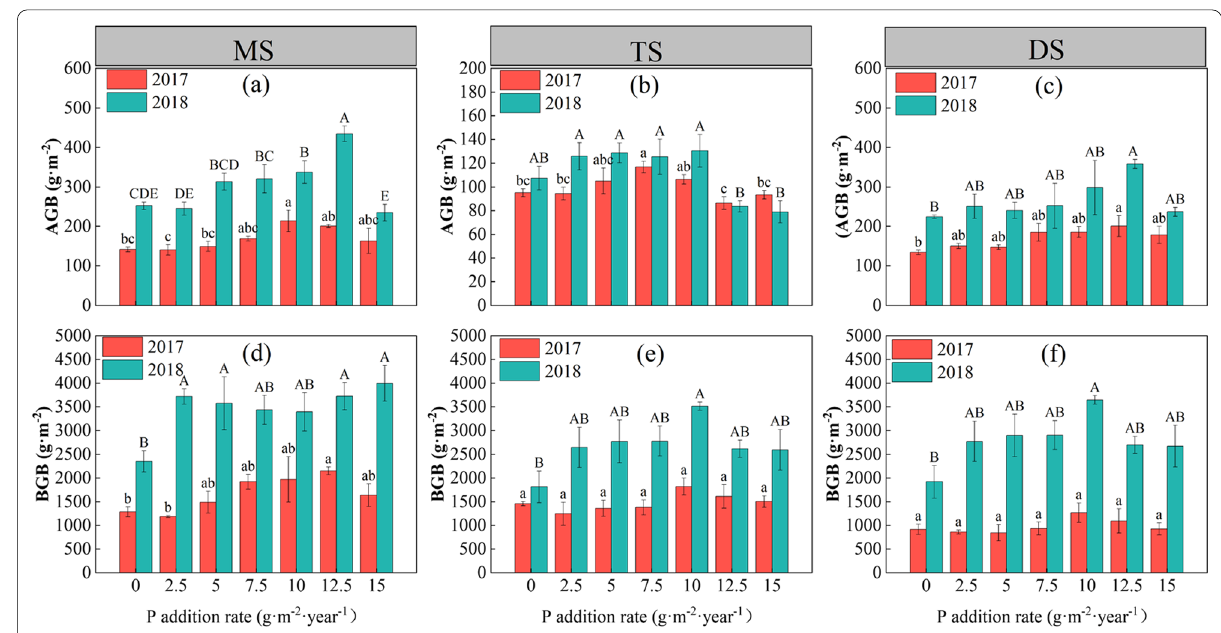
Bold font indicates a significant result ( P < 0.05)